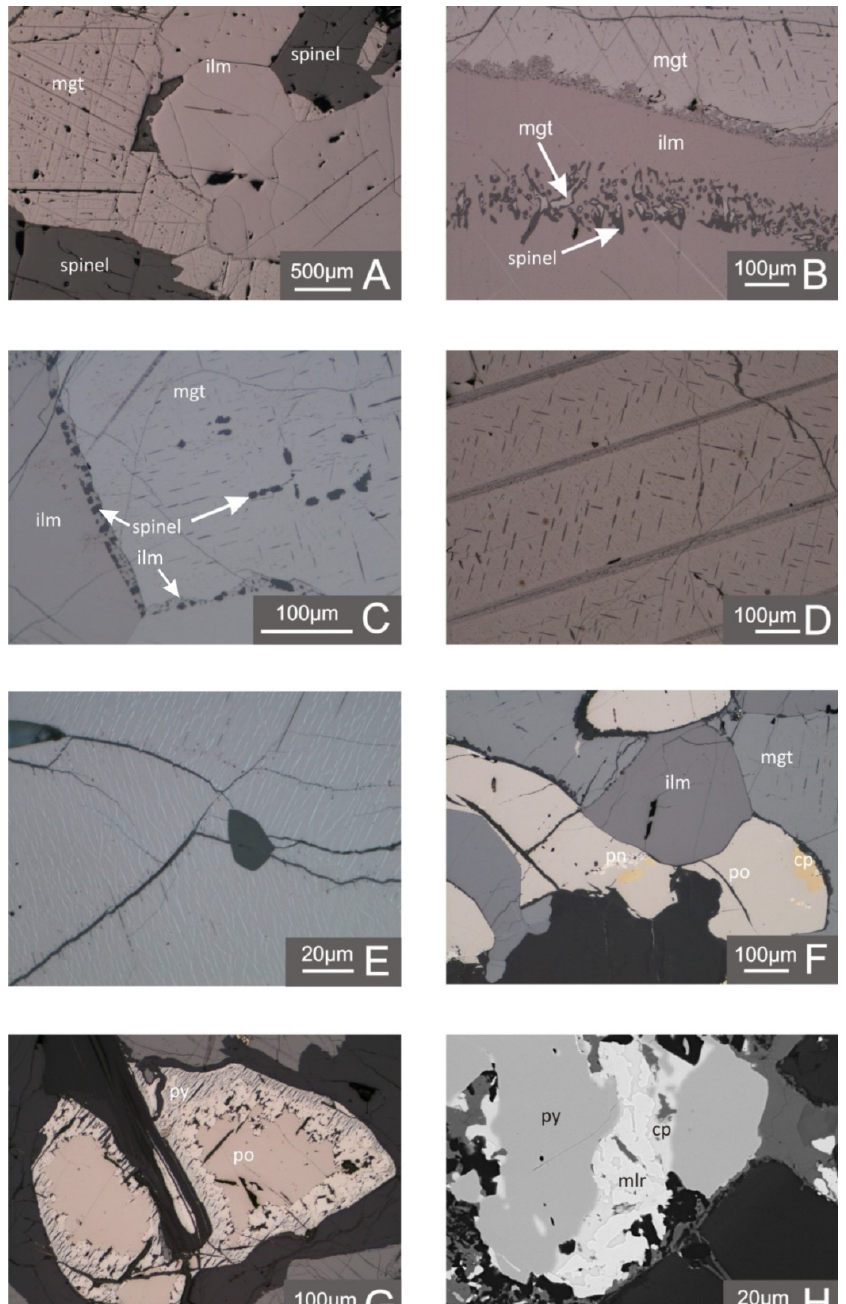
Figure 7. Microphotographs of characteristic oxide and sulphide ore mineralization from the Krzemianka and Udryn Fe-Ti-V deposits. ( A – G ) are reflected-light photomicrographs with crossed nicoles and ( H ) is a backscattered electron (BSE) image. ( A ) typical ilmenite-magnetite ore in the Krzemianka and Udryn deposits. Magnetite with exsolution of ulvöspinel, in association with ilmenite (ilm) and Al-spinels (spinel); ( B ) front of ilmenitization process on the border of magnetite (mgt) and ilmenite (ilm) is marked with Al-spinel grains. ( C ) exsolutions of ulvöspinel, ilmenite (ilm), and Al-spinels (spinel) in magnetite (mgt); ( D ) exsolutions of ulvöspinel in magnetite, and ilmenite laths; ( E ) ilmenite with hematite exsolutions; ( F ) typical sulphide (pyrrhotite—po, chalcopyrite—cp) aggregates in magnetite-ilmenite ore; ( G ) the pyrrhotite (po) is gradually replaced from the outer edges towards the center by pyrite (py); ( H ) millerite (mlr) replaces chalcopyrite (cp) in the pseudomorphs of pyrite (py) after pyrrhotite.